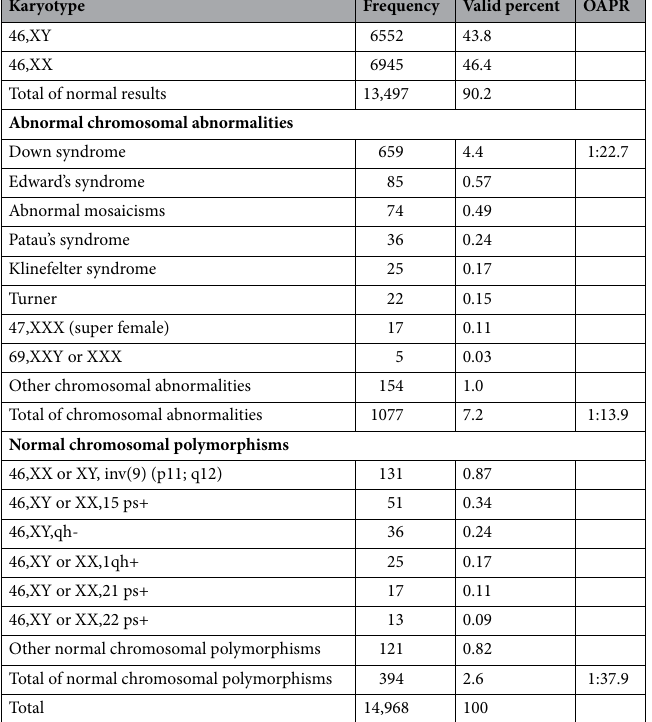
Table 3. Frequencies of different normal, abnormal and polymorphic karyotypes in fetuses (OAPR: Odds of being affected given a positive